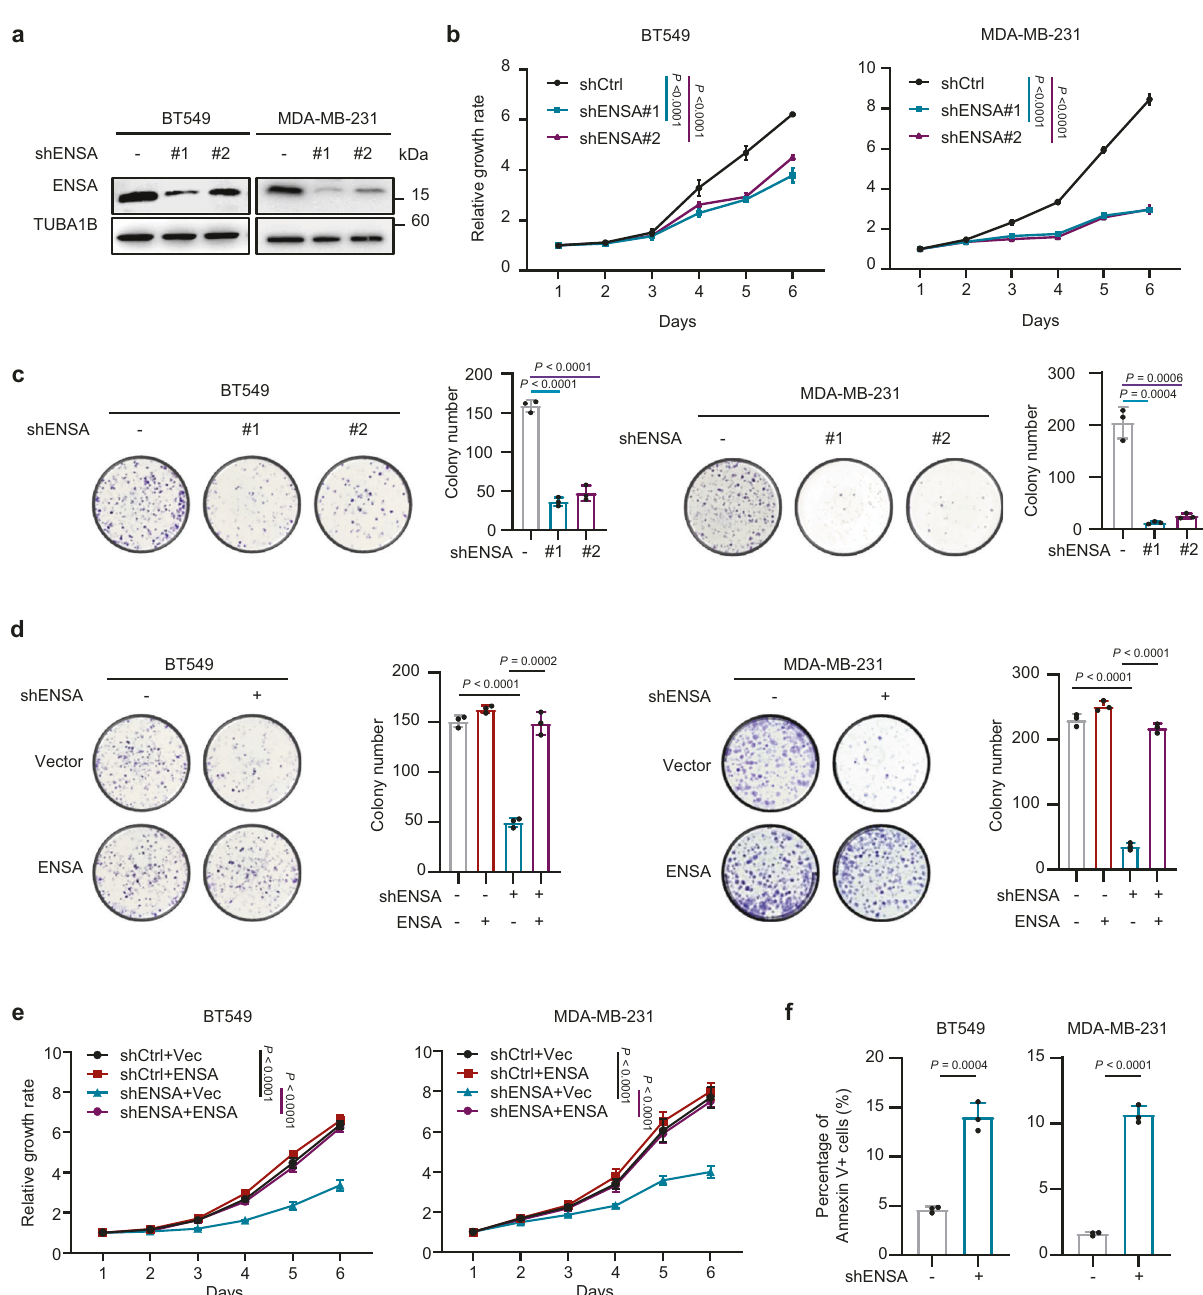
Fig. 2 ENSA is a major driver of TNBC cell growth. a Stable silencing of ENSA expression in the TNBC cell lines BT549 and MDA-MB-231. b In vitro growth curves of BT549 and MDA-MB-231 cells expressing control or ENSA shRNA. n = 6. Data are presented as mean ± SD. Two-tailed two-way ANOVA